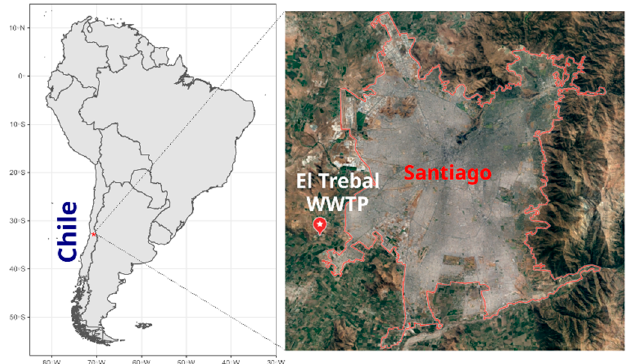
Figure 1. Map of el Trebal Wastewater Treatment Plant location in Santiago de Chile. El Trebal wastewater treatment plant (WWTP) is indicated by a white-star red baloon.